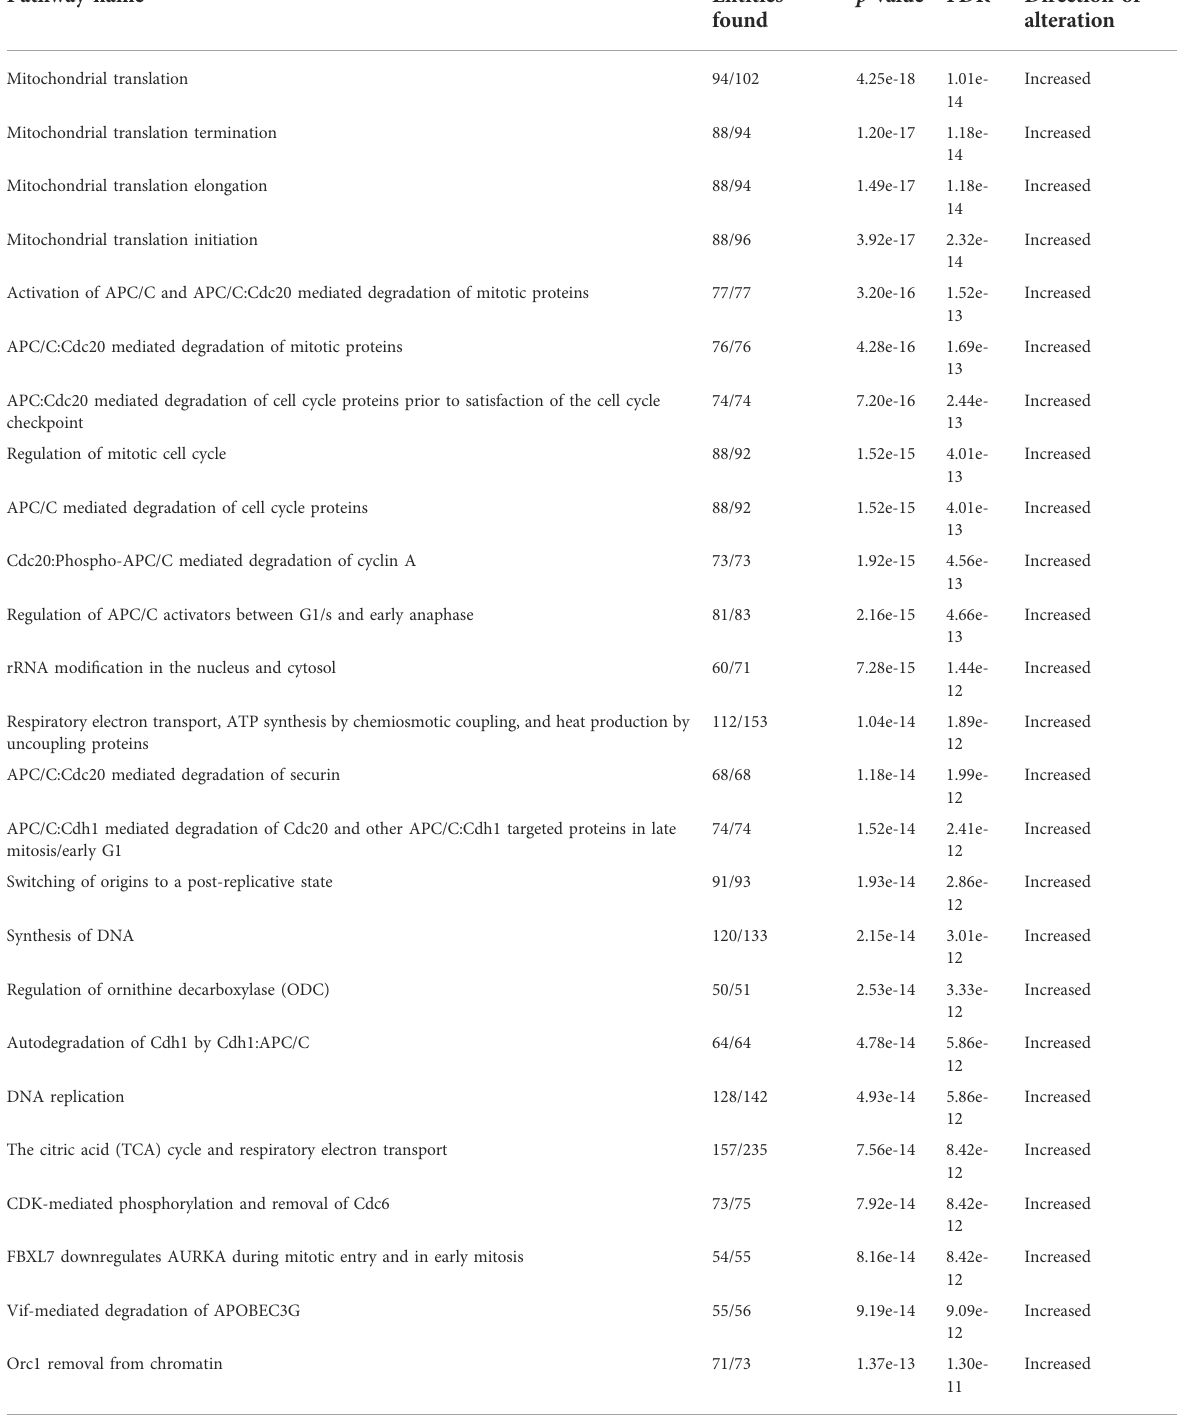
TABLE 3 RNAseq pathway analysis of ACM vs. RPMI (all cell lines